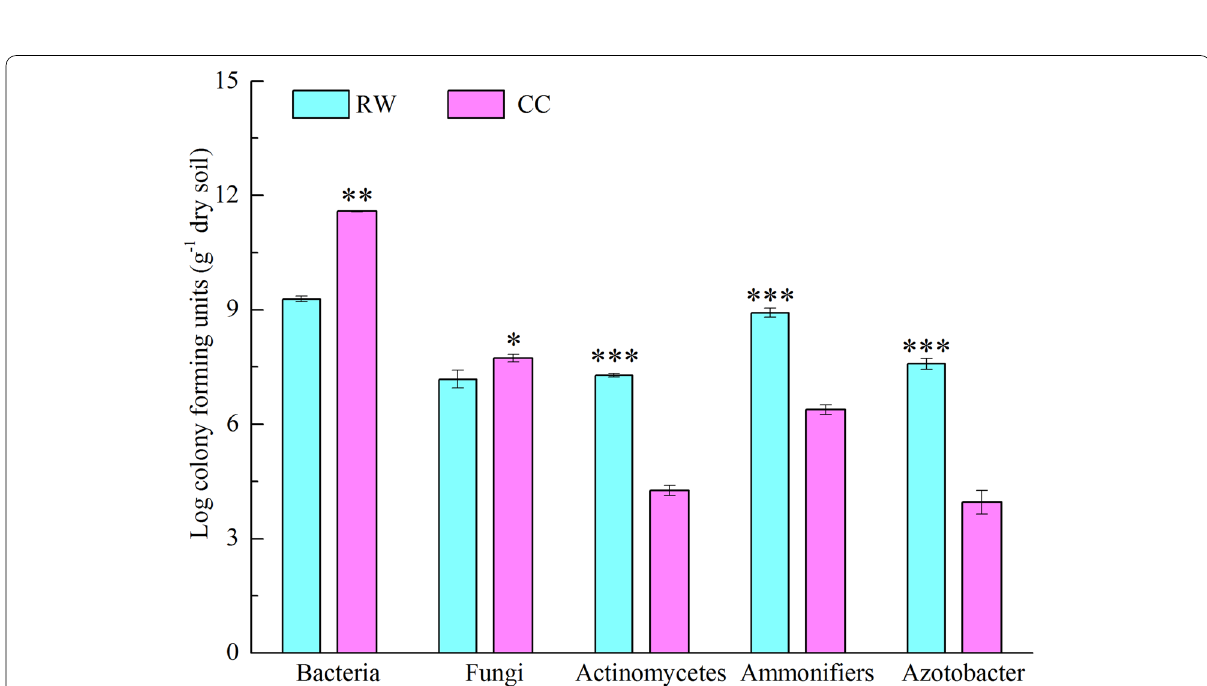
Fig. 2 Comparisons of the cultural microbial populations in rhizosphere soil of A. sinensis seedlings between RW and CC. Significant differences were determined using least significant differences ( LSD